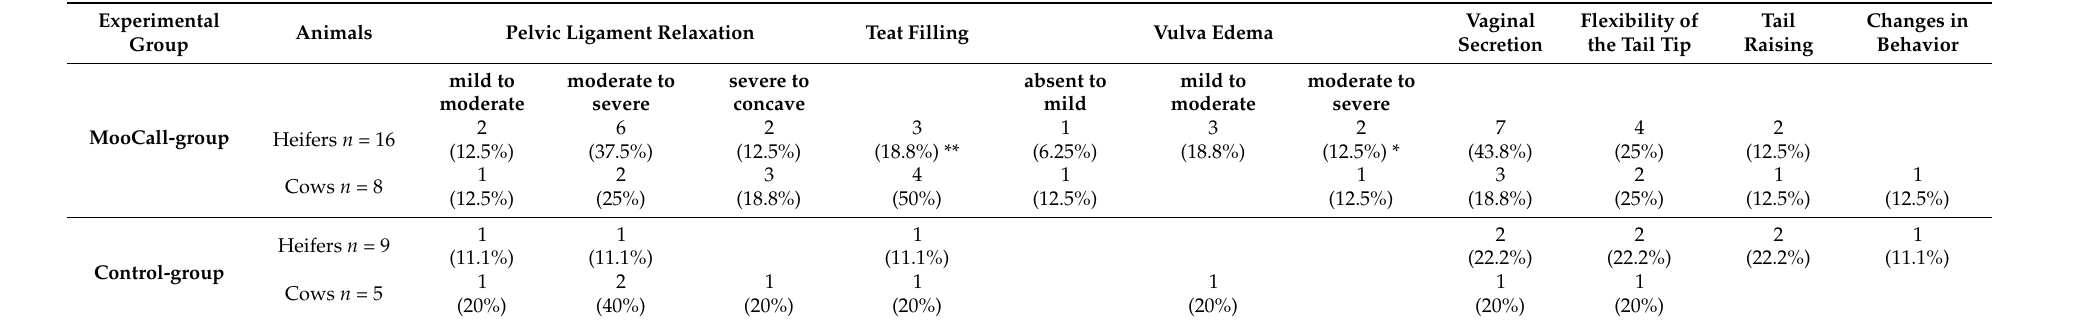
Table 1. Number of animals (n, percentage (%)) sorted by age (cows vs. heifers) and experimental group (animals instrumented with the remote calving sensor Moocall ® (Moocall group) vs. Control group) that conveyed changes in pelvic ligament relaxation, teat filling, vulva edema, vaginal secretion, flexibility of the tail tip tail raising, and changes in behavior 24 h prior to